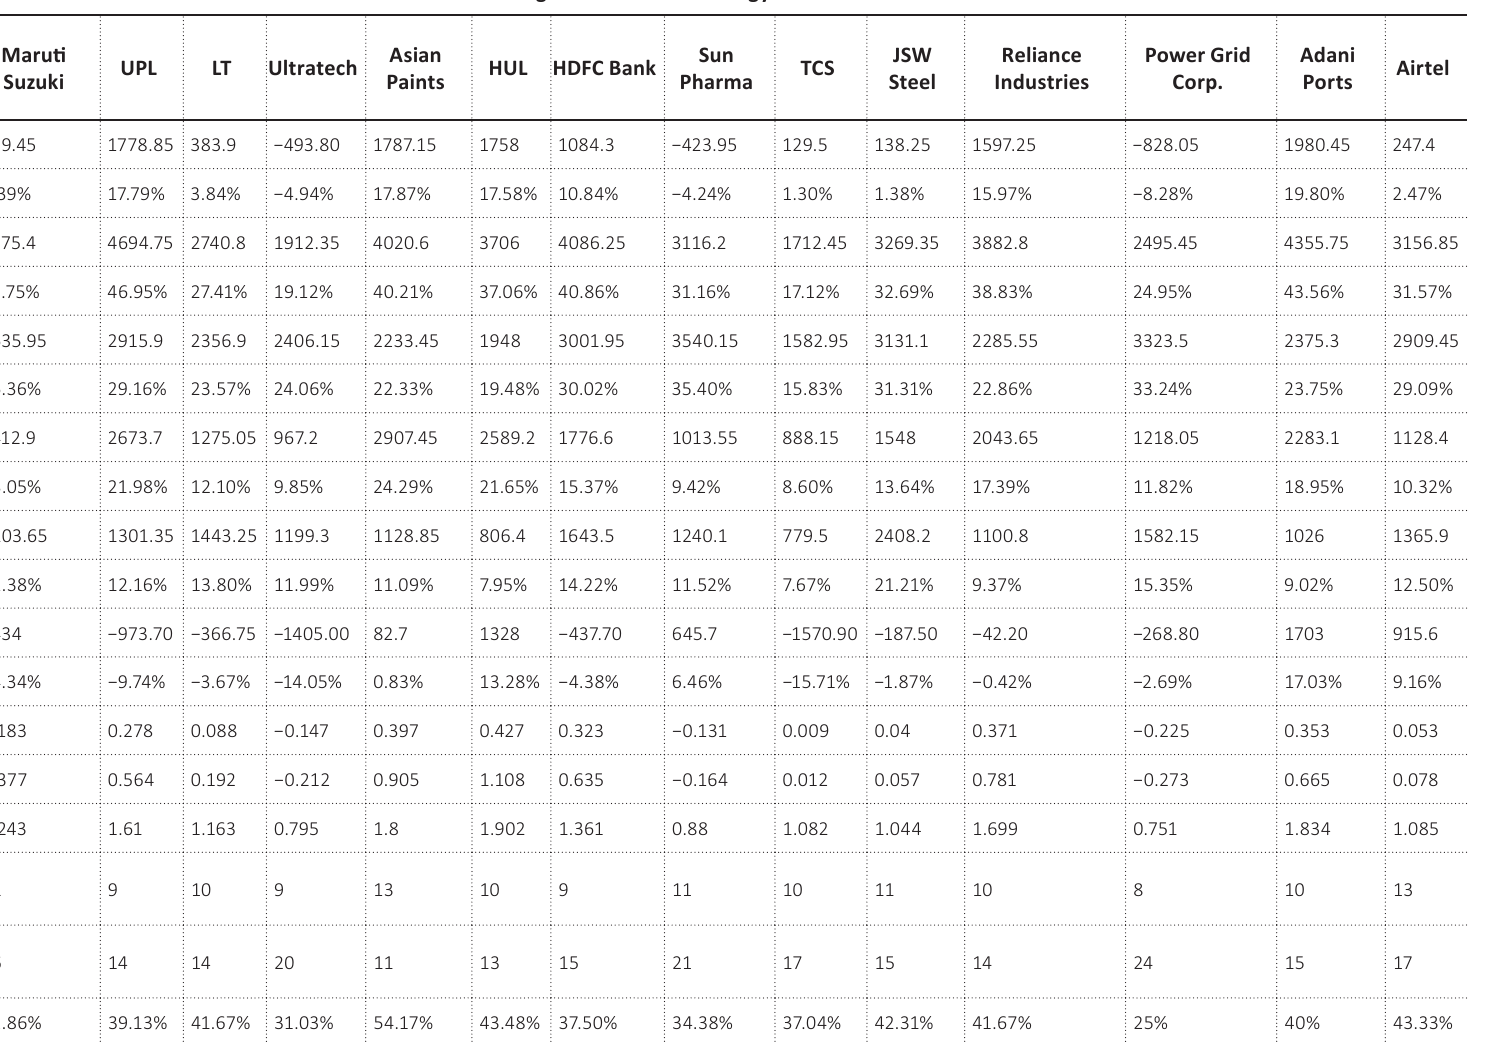
Bollinger Bands & RSI